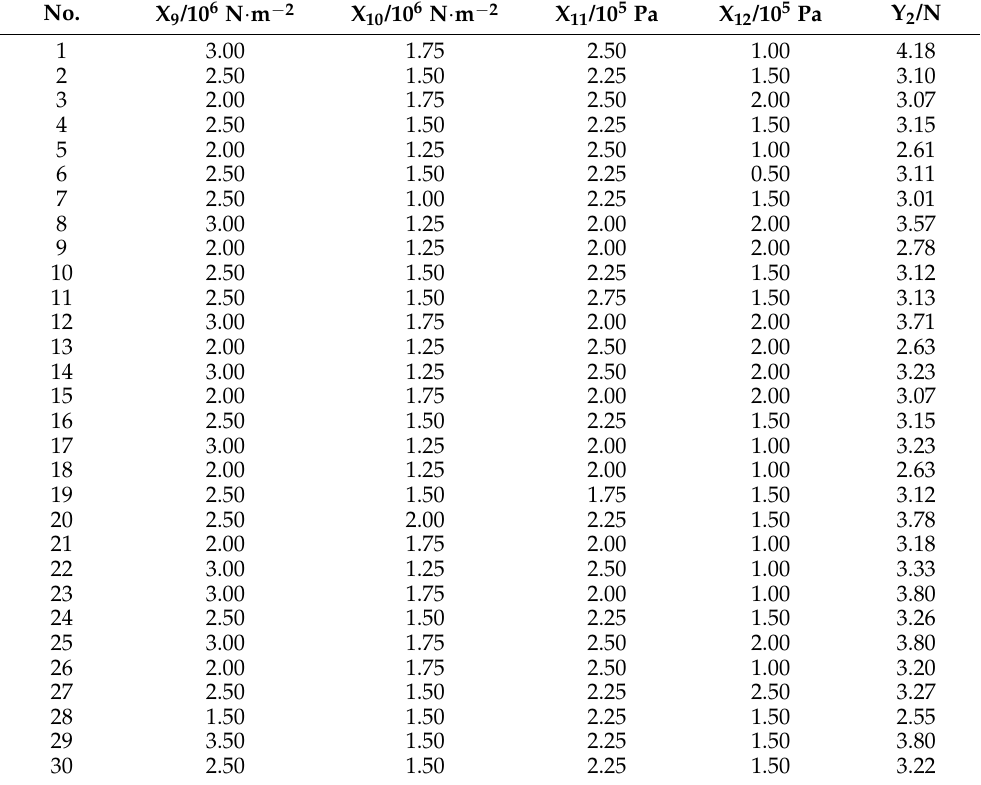
Table 9. The soil blocks shear response surface test and results.